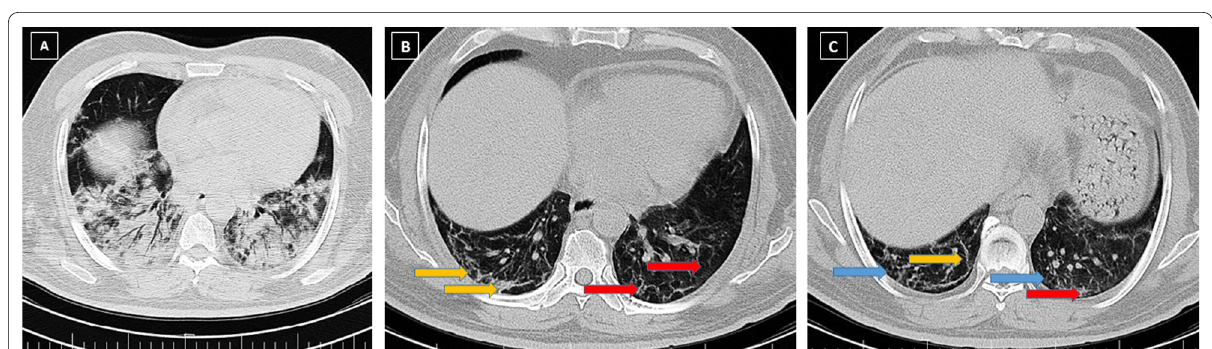
Fig. 2 A 55-year-old male patient presented with fever, dyspnea and sputum discharge, who was admitted to hospital and was discharged on day 19 of admission. Ground glass opacities and consolidations in multiple pulmonary lobes are observed in the initial CT scan ( A ). The total CT severity score was calculated as 23, and the disease severity was severe. Three-month ( B ) and 6-month ( C ) follow-up CT shows parenchymal bands (yellow arrows), interlobular septal thickening (red arrows), and vacuolation (blue arrows), which were persistent findings without any significant changes after 3